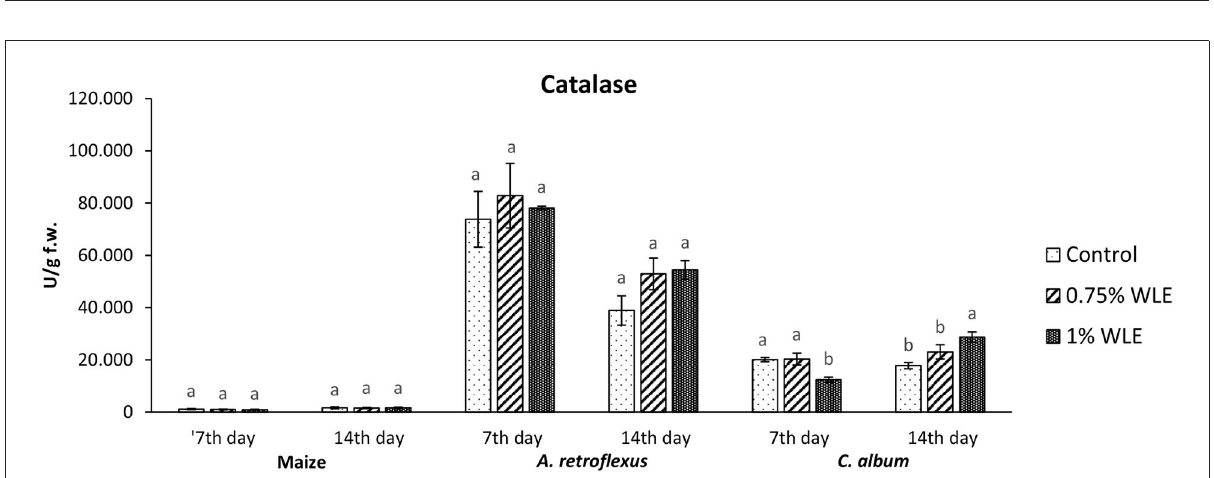
FIGURE6 Activity of antioxidant enzyme catalase (CAT) in maize and weeds - Amaranthus retroflexus and Chenopodium album as a response to treatment with 0.75 and 1% walnut leaf extract, on the 7 th and 14 th day after treatment. Data are presented as mean ± SD. Values marked with different letters within a group differ significantly based on Tukey’s HSD test ( p ≤